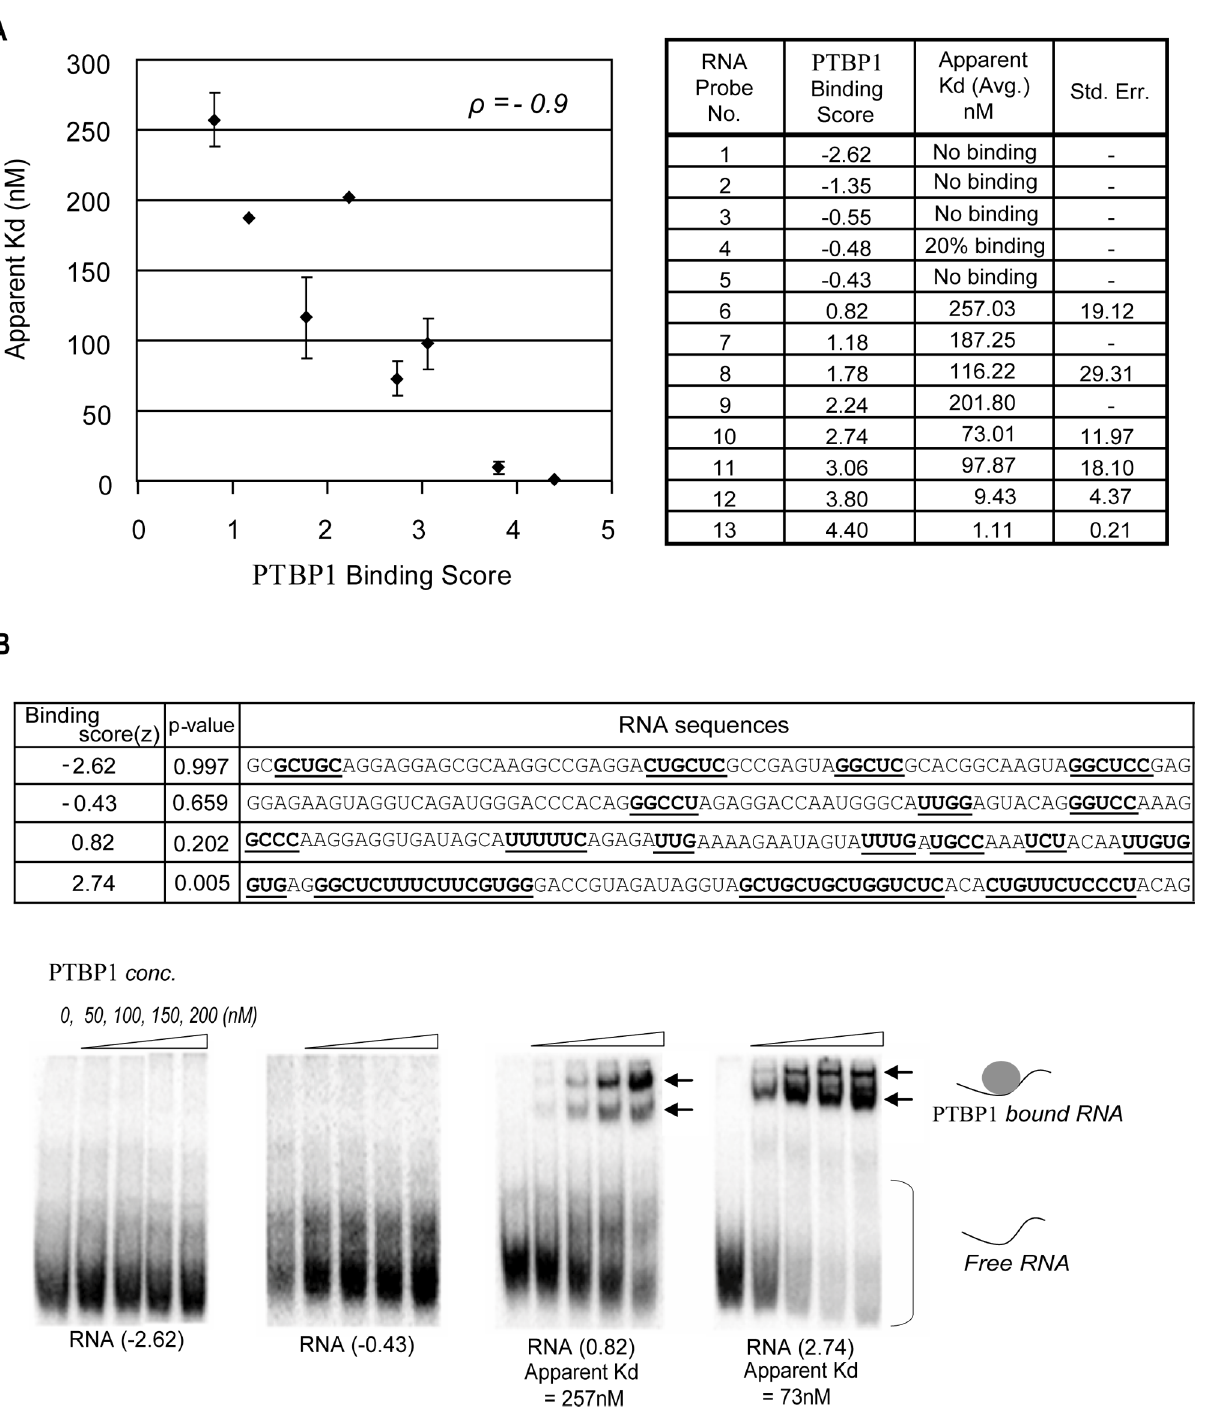
Figure 2. Validation of the PTBP1 binding model. A . To validate binding scores, thirteen RNAs with various PTBP1 binding scores were transcribed in vitro and subjected to binding assay. Apparent Kd ’s (dissociation constant) were highly negatively correlated with PTBP1 binding scores (Pearson correlation= 2 0.9). B . Four RNA sequences with predicted PTBP1 binding scores (Full data binding data in Figure S3). Potential PTBP1 binding sites are underlined and in bold. Experimental binding affinities were assessed by electrophoretic mobility shift of RNA by PTBP1 and compared with prediction scores. Apparent dissociation constants ( Kd ) were defined as the concentration at which half the protein was bound to RNA. binding sites within the downstream intron relative to control (Figure 3A). Similar to what was seen in the previous study by exons, although the distribution of binding sites across this region Llorian, we found little enrichment of PTBP1 sites within was different between the repressed and enhanced exon sets enhanced exons [19]. There is a limited enrichment adjacent to